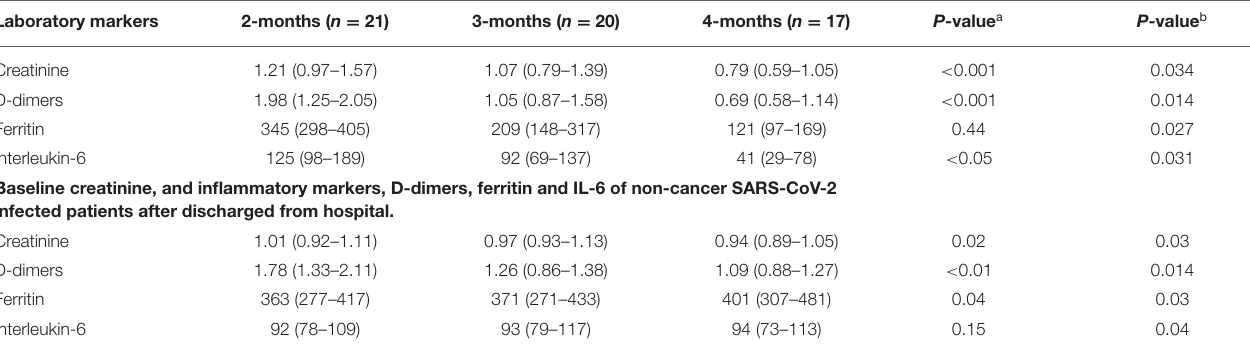
TABLE 6 | Baseline creatinine, and inflammatory markers, D-dimers, ferritin and IL-6 of patients with cancer who underwent chemotherapy before SARS-CoV-2 infection. Laboratory